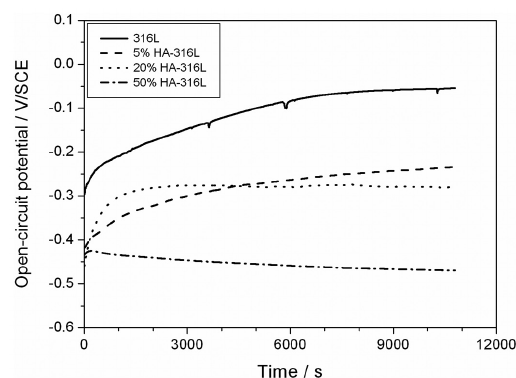
Figure 2. Variation of open-circuit potential with time for sintered 316L stainless steel and HA‑316L composites in Ringer’s solution at room